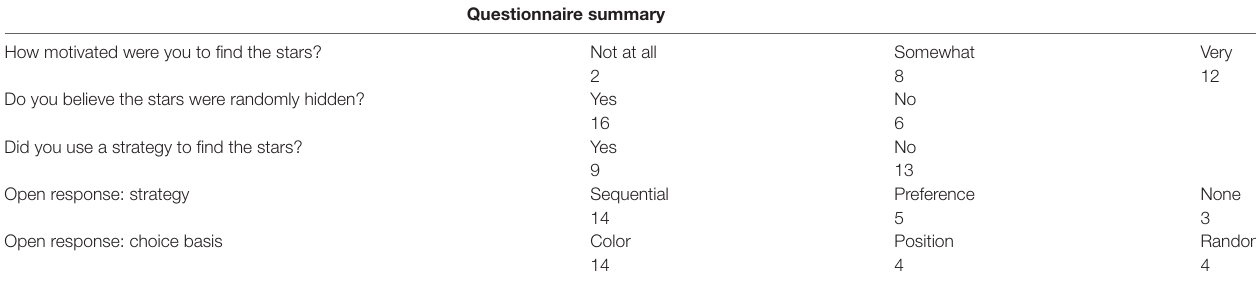
TABLE 1 | Summary of participant responses from questionnaire provided on task completion.